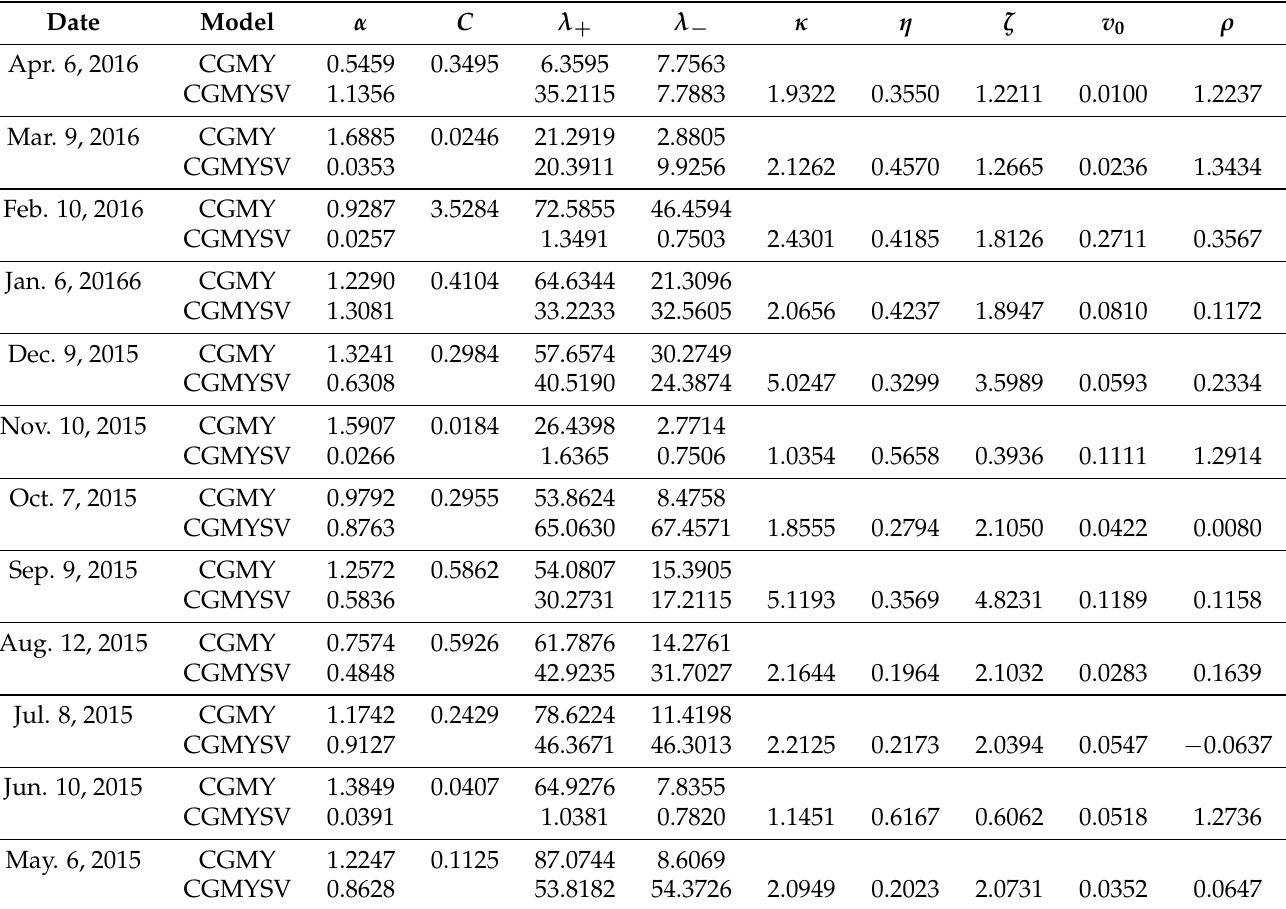
Table 5. Parameter Calibration Results for the OEX Option